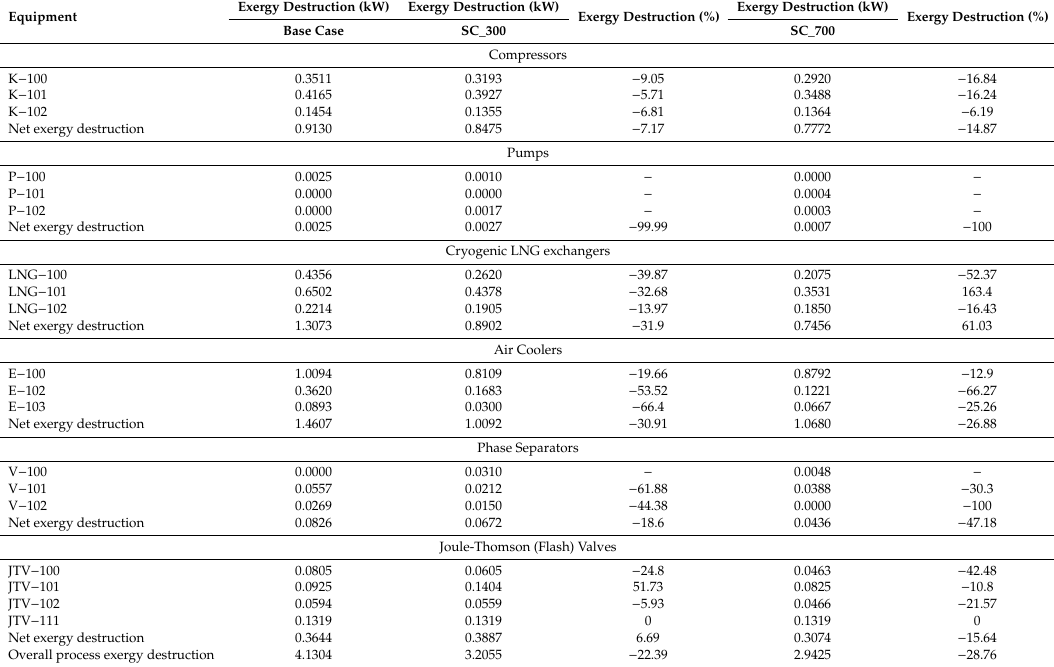
Table 6. Exergy destruction in terms of destruction / gain compared to base case.